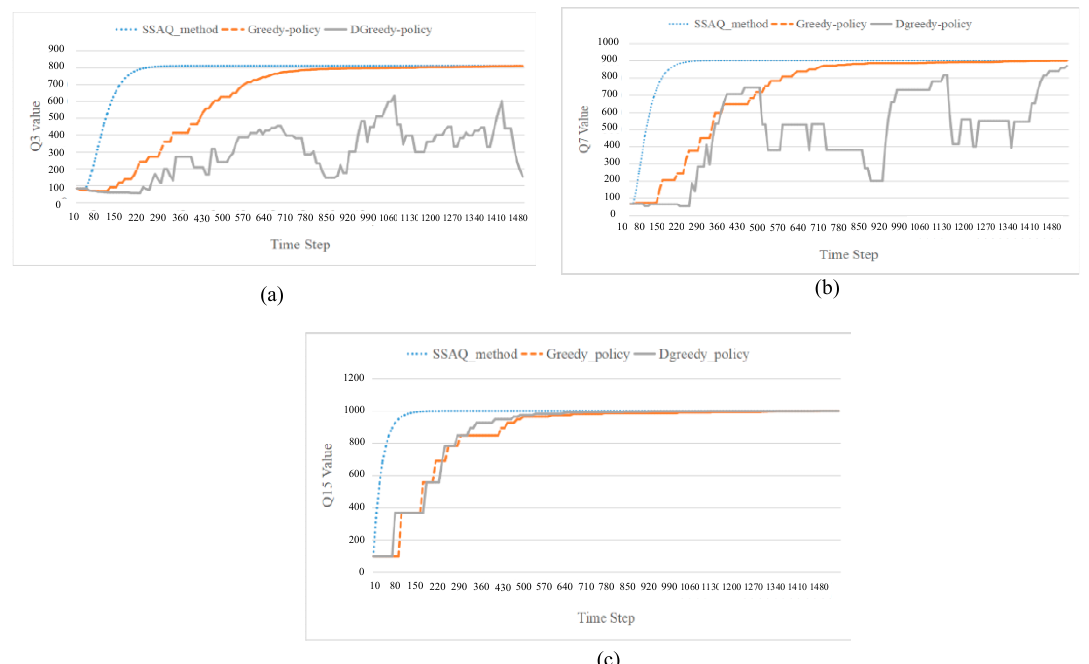
Q ; ( b ) The change curve of Q ; 3 7